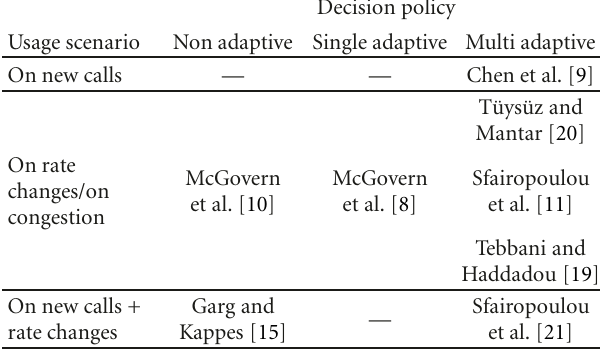
Table 1: Comparison of codec-based solutions to multirate